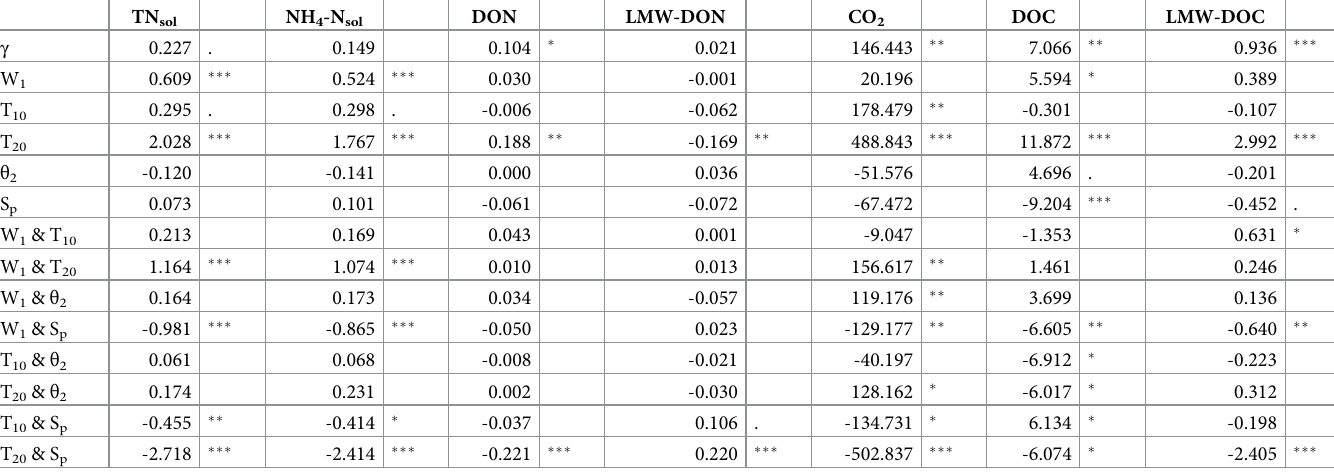
Table 3. Change rate ( μ g g -1 day -1 ) in dissolved N and C pools and CO 2 release during the incubation calculated using mixed linear effect models (Eq 1). Parameter γ represents the change rate for mor (S m ), no worms (W 0 ), lower moisture status ( θ 1 ) at 5˚C temperature (T 5 ). The other treatment effects and the interaction effects (from W 1 to T 20 & S p ) are expressed as a difference with respect to γ